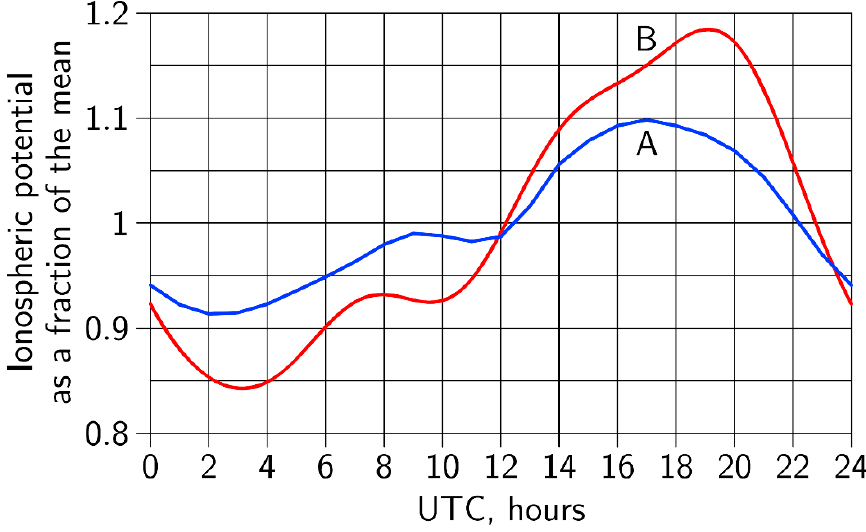
Figure 7. Simulated diurnal variation of the total IP as a fraction of the mean (A) and classical Carnegie curve (B, after Harrison, (2013) [33]).